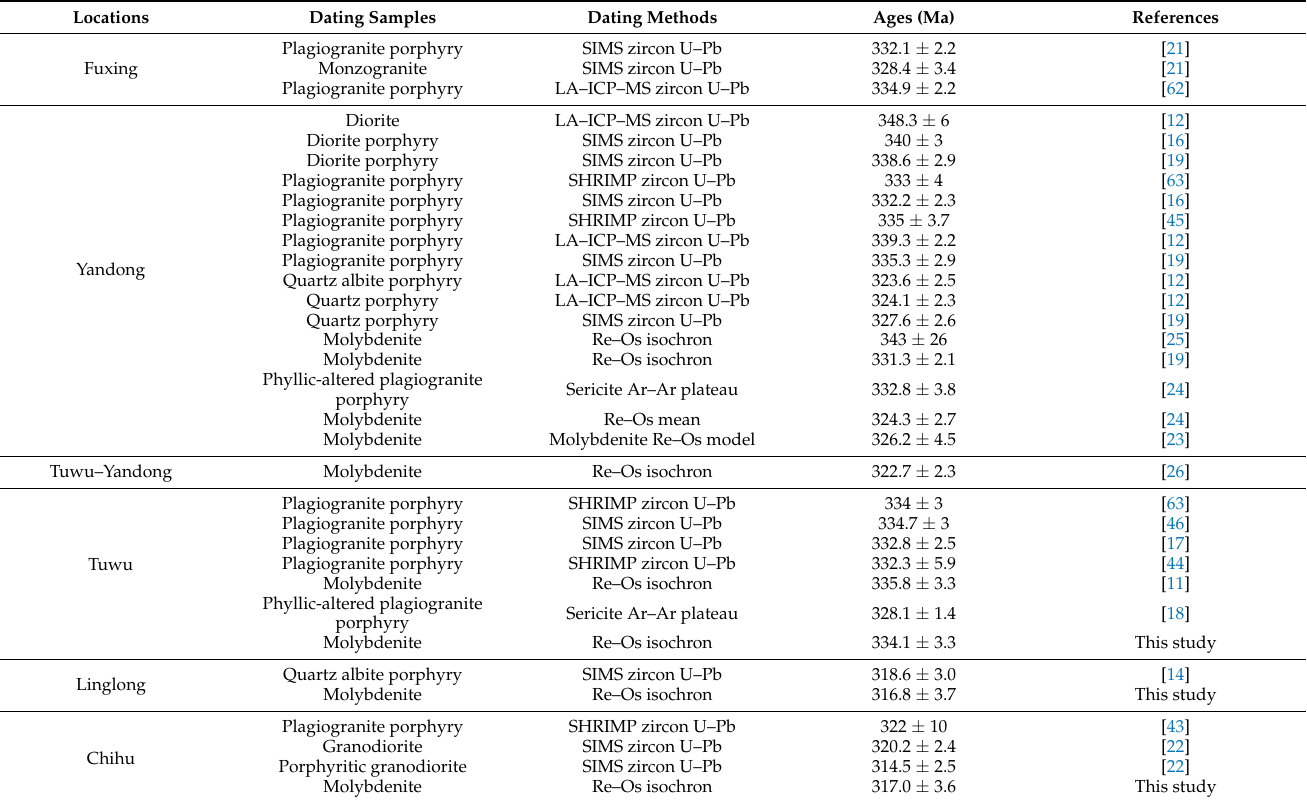
Table 3. Isotopic ages of porphyry Cu deposits in the Tuwu–Yandong